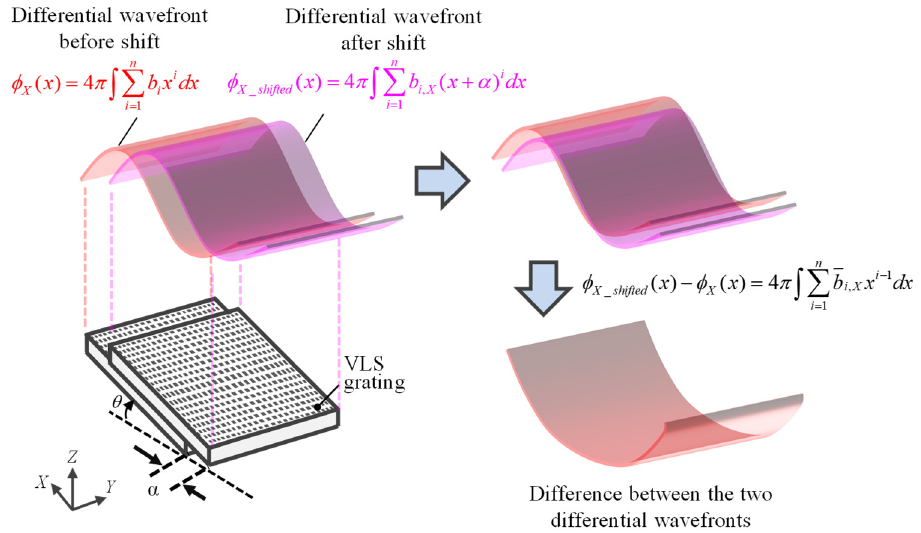
Figure 2. A new method integrating an interferometric pseudo-lateral-shearing method: ( a ) A sche- matic of the measurement procedure for calibration of the VLS parameters of the large-scale VLS grat- ing; ( b ) A schematic showing the concept of the proposed method based on pseudo-lateral-shearing (In each of the three measurements, the interferometer is fixed with respect to the VLS grating).